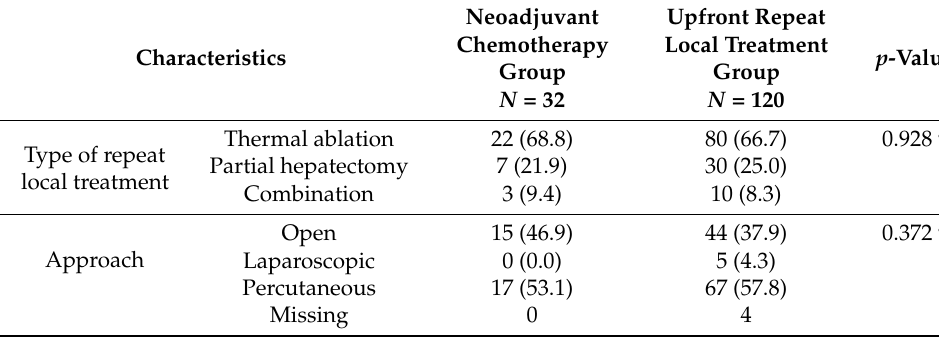
Table 2. Treatment characteristics per patient of repeat local treatment.